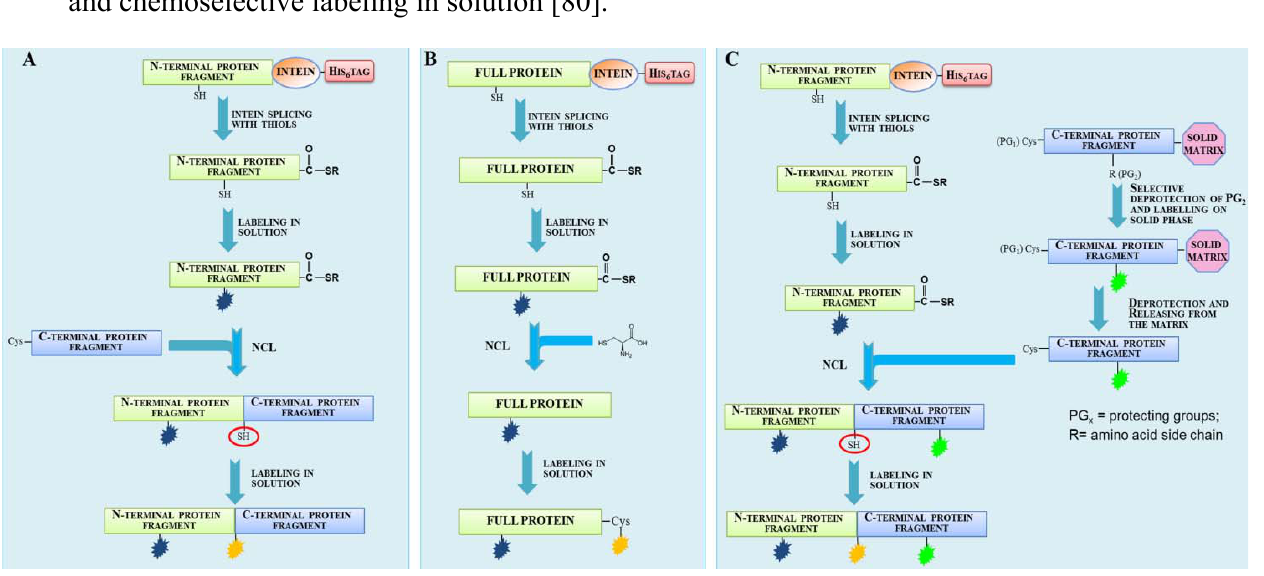
Figure 7. Schematic procedure to prepare double/triple modified proteins combining EPL and chemoselective labeling in solution